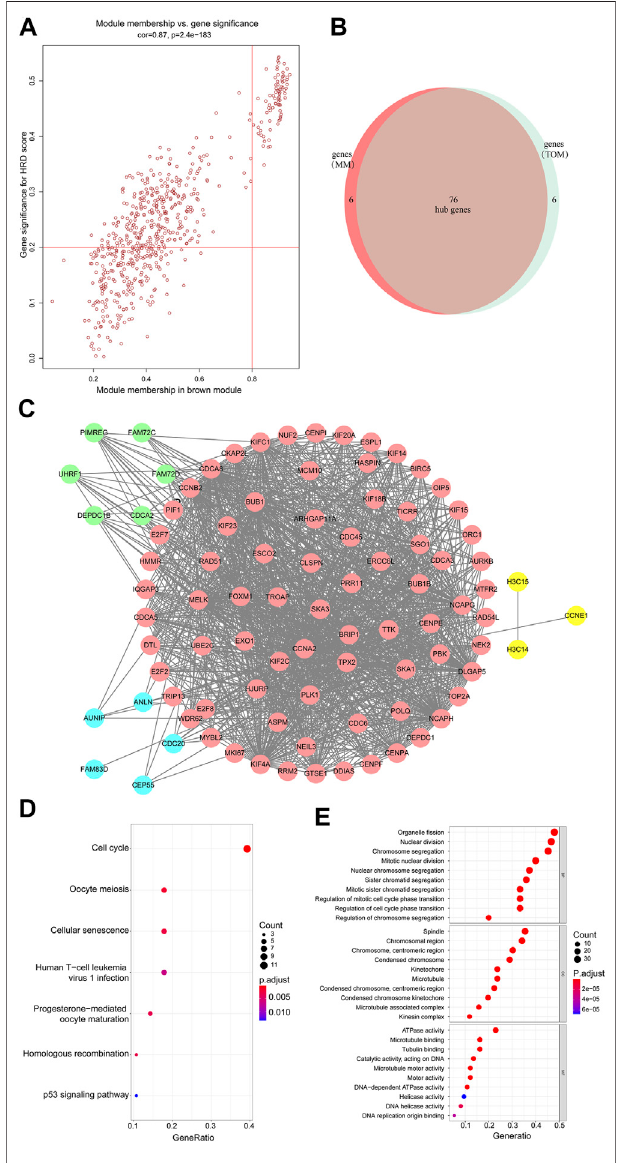
FIGURE 3 | (A) Scatterplot of gene signi fi cance related to module membership in the brown module. (B,C) 76 hub genes were identi fi ed. (D) KEGG enrichment analysis of the differentially expressed genes shown as a scatterplot. The enrichment degree of KEGG was measured by the number of genes enriched to this pathway. The horizontal coordinate is the gene ratio. Thegreater thevalueofthe generatio, greater willbe thedegree of enrichment. The vertical coordinate is the pathway term with high enrichment. The size of the dot indicates the number of different genes under this term; largerthedot,higherwillbethenumberofgenes. (E) GOanalysisofpredicted genes according to the values in the enrichment score under the themes of biological process (BP), cellular components (CC), and molecular function (MF). Color represents translational values about log10 of q value, and size represents the number of genes enrichment. The horizontal axis represents the proportion of gene enrichment. The GO enrichment analysis classi fi es genes according to their different